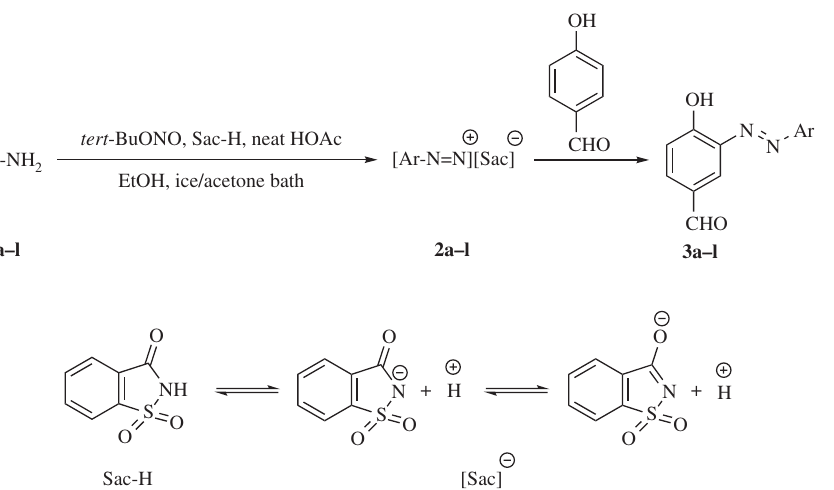
Scheme 1: Modified Knoevenagel’s method for synthesis of 4-hydroxy-3-[( E )-aryldiazenyl]-benzaldehyde derivatives via stable arenediazo- nium